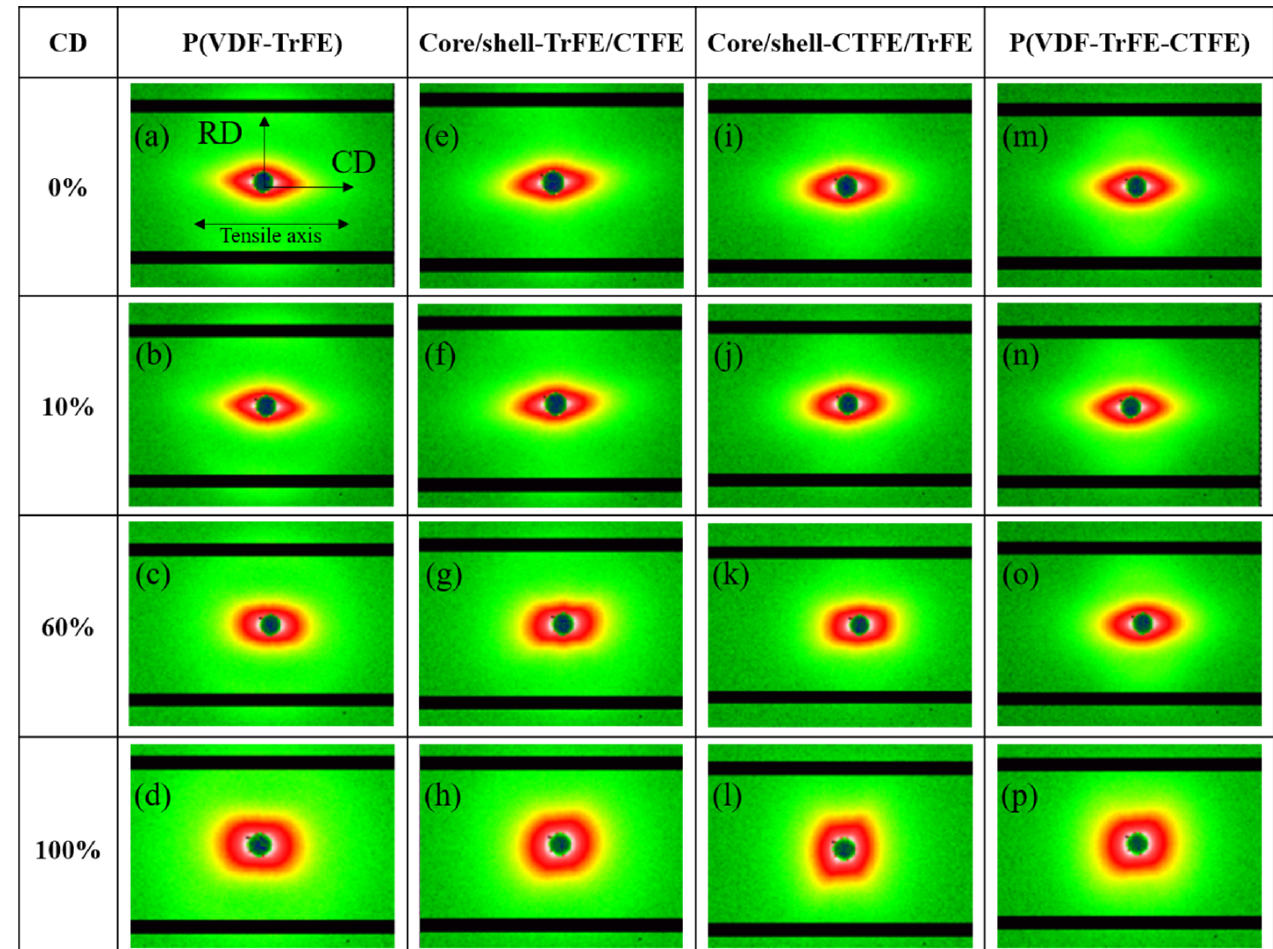
Figure 6. 2D SAXS patterns in the single and coaxial electrospun membranes at the designated strains in CD. ( a , e , i , m ) Nanofibers are oriented in a preferred orientation normal to the tensile axis, indicated by an elliptical shape of the diffraction pattern. ( b , f , j , n ). Nanofibers are slightly deformed along the tensile axis, indicated by an elliptical shape of the unchanged diffraction pattern. ( c , g , k , o ) Nanofibers are reoriented towards the tensile axis, indicated by a square-like shape of the diffraction pattern. ( d , h , l , p ) Nanofibers are further reoriented to the tensile axis, indicated by a disk-like shape of the diffraction